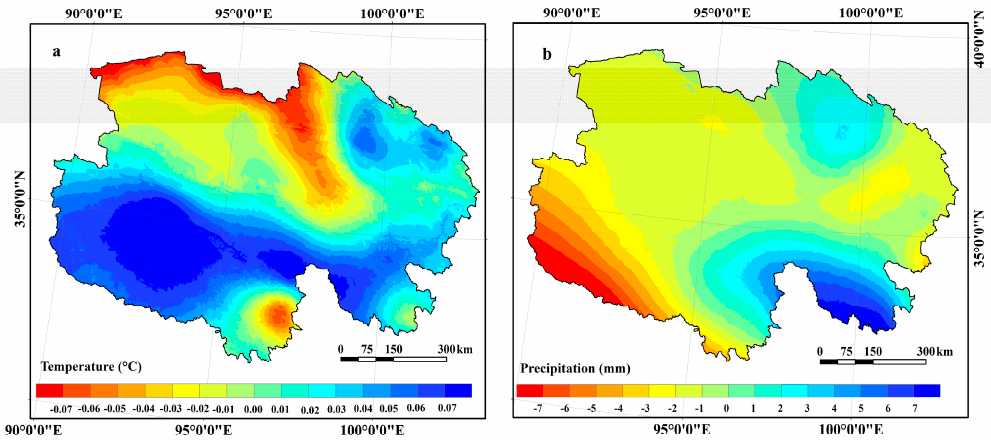
Figure 5. Spatial patterns of driving forces for NPP a changes from 2001 to 2016. 249